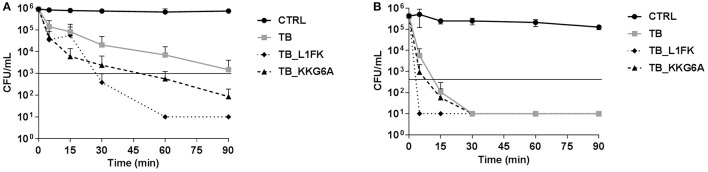
Killing kinetics of TB, TB_L1FK, and TB_KKG6A against S. aureus ATCC 33591 (A) and P. aeruginosa ATCC 27853 (B). Bacteria were incubated in sodium-phosphate buffer (10 mM SPB, pH 7.4) with the peptides at concentrations equal to their MBCs for various times. Control (CTRL) represents untreated bacteria. Solid line indicates a reduction of ≥3 Log10 in the number of control bacteria at each time of incubation. A number of 10 CFU/mL was taken as detection limit. Data are expressed as mean ± standard error of at least three independent experiments.